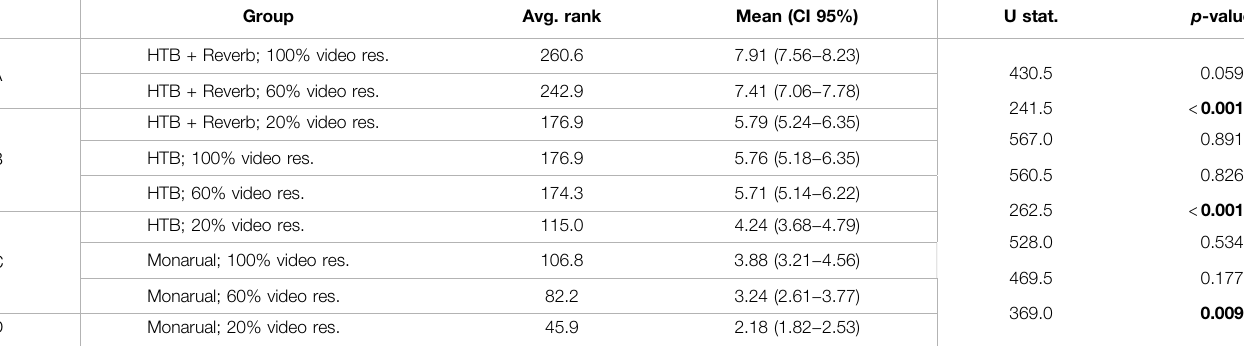
TABLE1| Immersionscorespairwise(step-down)comparisonusingMann-WhitneyUtests.Thegroupsareorderedintermsofsampleaveragerankandthestatisticaltests are applied between successive groups (which is indicated visually by the half-row offset of the last 2 columns). The 95% con fi dence interval for the mean is